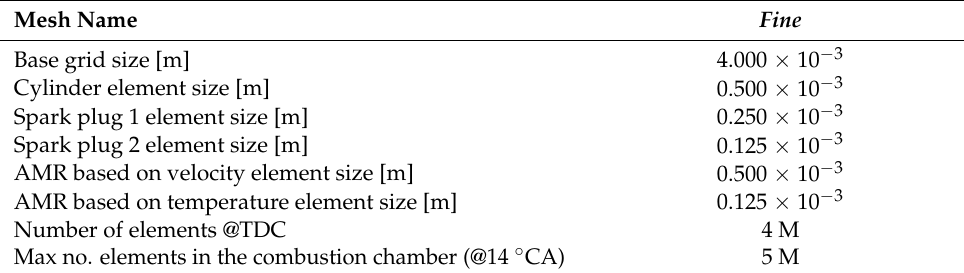
Table 3. Mesh properties for the selected computational grid.